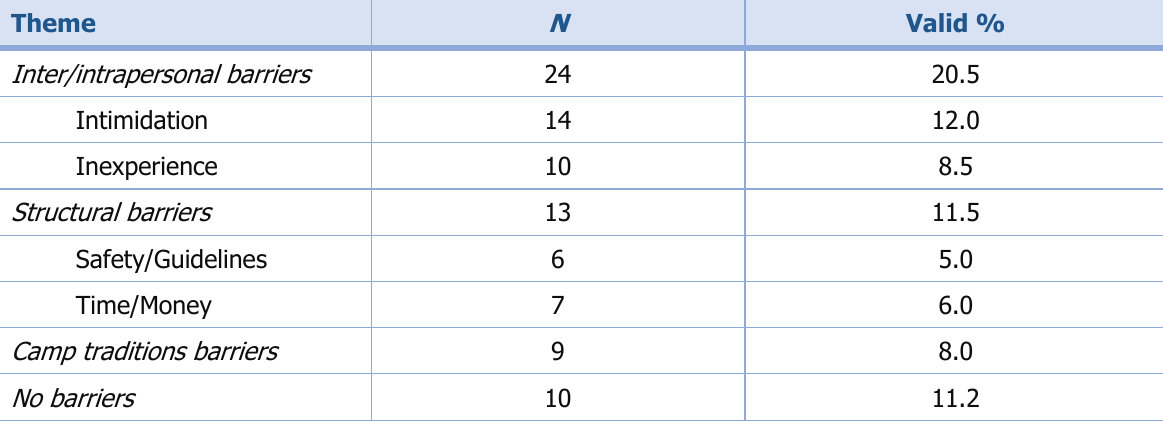
Table 5: Frequency of categories of barriers and creativity (n = 46) Theme N Valid % Inter/intrapersonal barriers 24 Intimidation Inexperience Structural